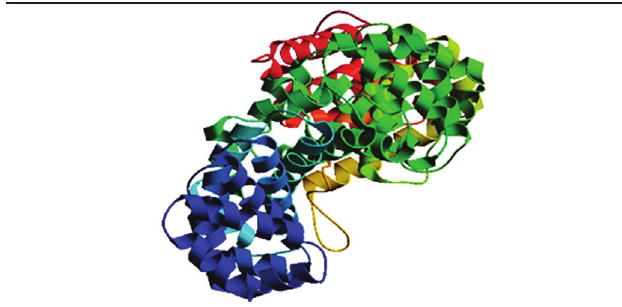
figurE 12 − CTNNB1 catenin beta 1 [ Homo sapiens